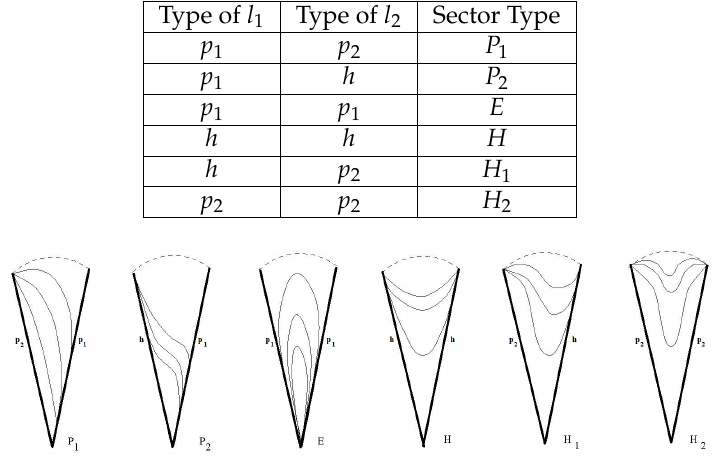
Figure 3. Non exceptional types of